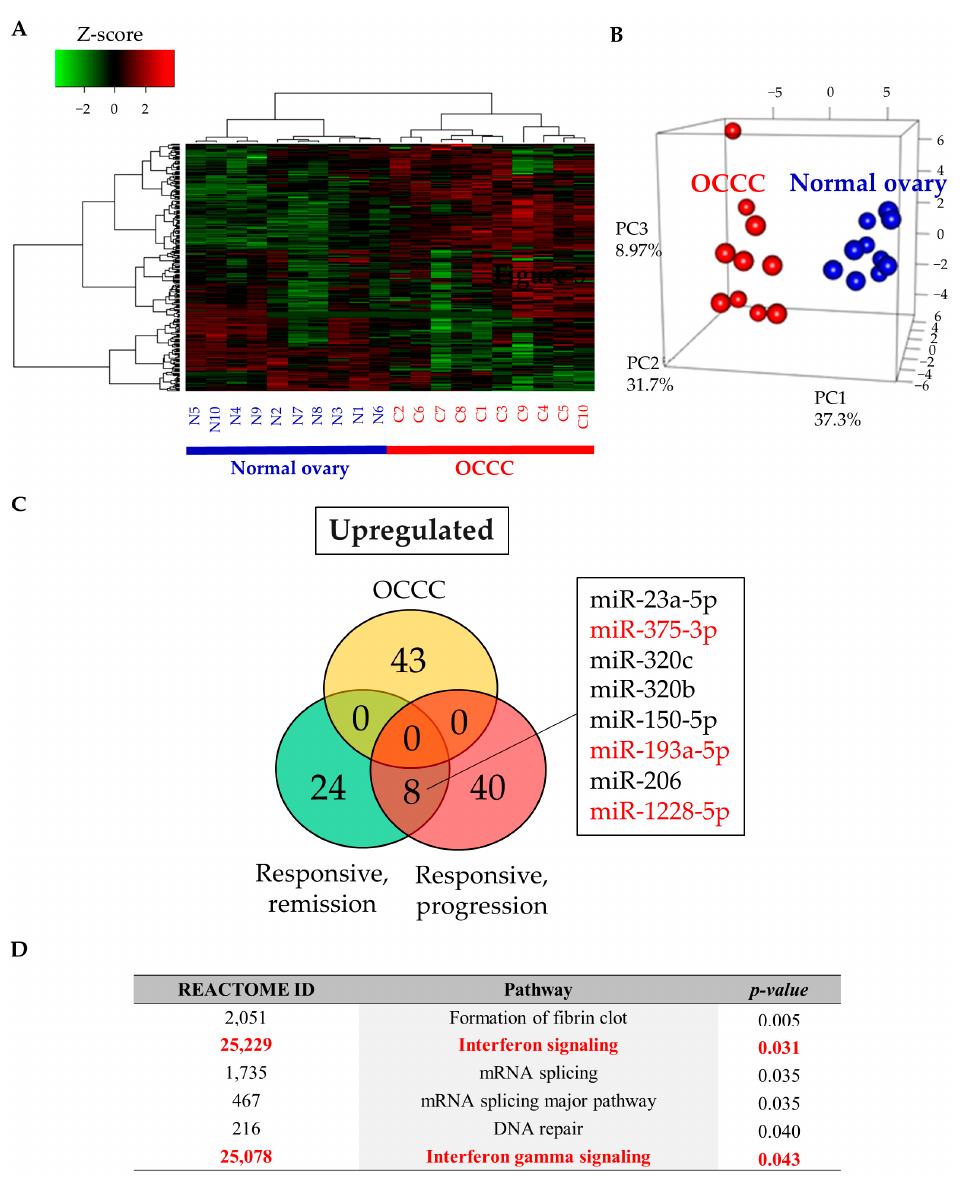
Figure 5. Comprehensive miRNA sequencing in FFPE tissues of OCCC and normal ovaries. ( A , B ) Heatmap and principal component analysis of tissue miRNA profiling. N: normal ovary, C: ovarian clear cell carcinoma; ( C ) Venn diagram showing upregulated miRNAs in OCCC FFPE tissue and serum samples (Studies 1 and 2). Responsive, remission: responsive subgroup in the remission group (Study 1), Responsive, progression: responsive subgroup in the progression group (Study 2); ( D ) functional annotation of the three miRNAs using miRSystem (http://mirsystem.cgm.ntu.edu.tw/).